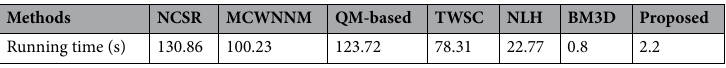
Table 7. Running time of various denoising methods